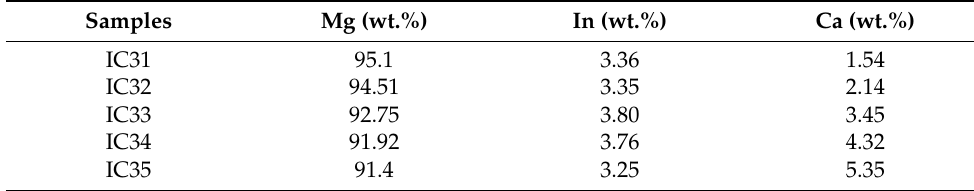
Table 1. Composition of casting